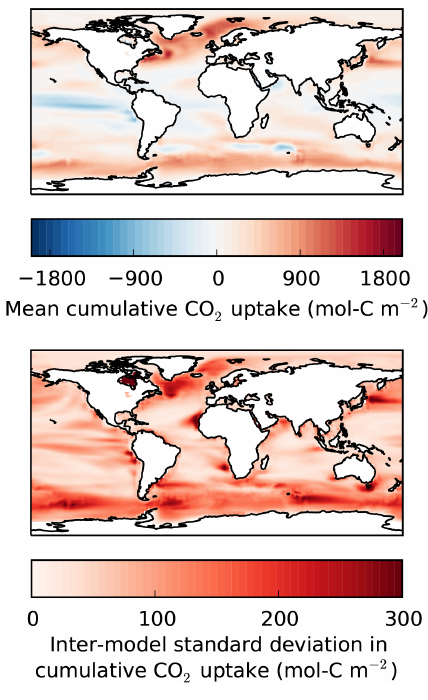
Figure 2. Cumulative sum of air–sea CO 2 flux between the years 1860 and 2100 (RCP8.5). (a) Mean and (b) inter-model standard deviation across